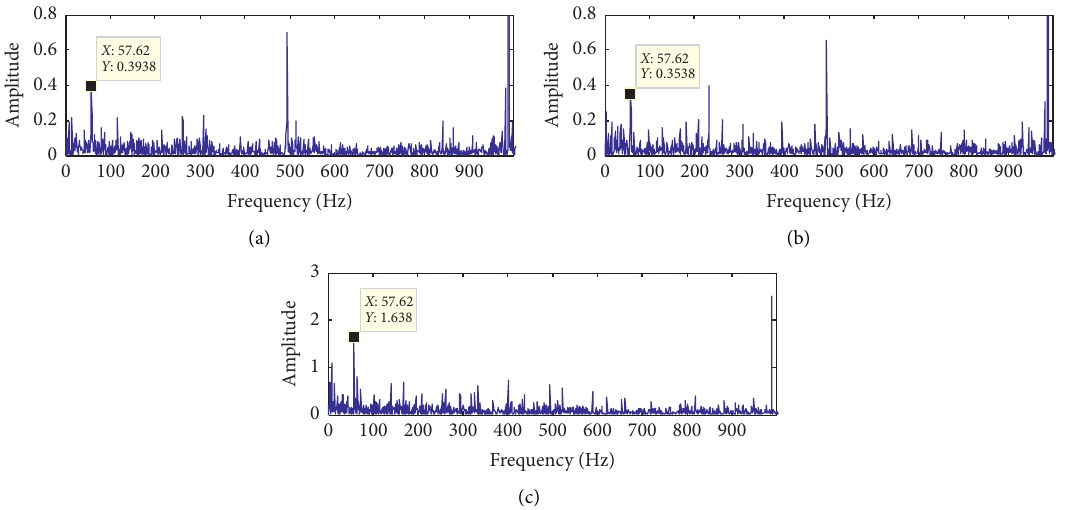
Figure 12: The envelope spectrums in the test for bearing 3# of testing 1 at different operating moments: (a) the trigger value of the proposed method at point 902, (b) the trigger value of the compared method at point 1664, and (c) the breakdown value of the whole-life bearing at point 2000.